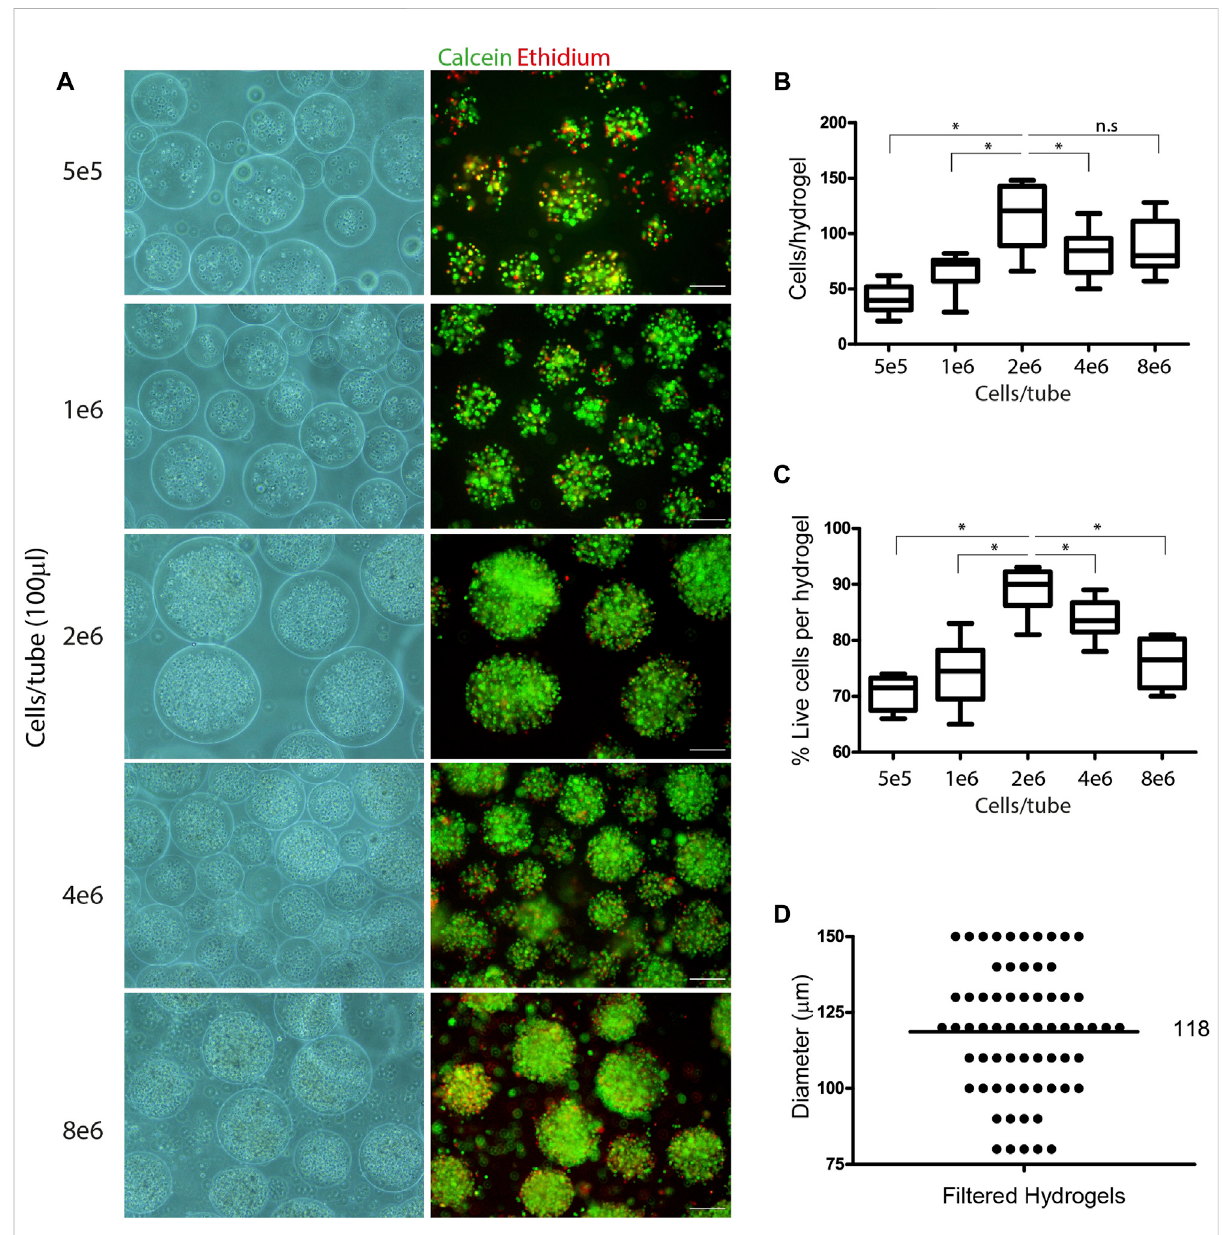
FIGURE 1 Co-encapsulation of alveolar macrophages (MH-S) and epithelial (TC1) cells inside hydrogel microspheres. (A) Representative bright fi eld and fl uorescentimagesofencapsulatedMH-Scellsinelevatednumberofcellsperreaction(5×10 5 -8x10 6 cells/100 µlinaglasstube).Encapsulatedcells werestainedwithCalcein(green)andethidium(red)forlive/deadassay.Scalebar100 µm. (B) Boxplotshowingmedianofencapsulatedcellnumber per hydrogel microspheres using elevated number of cells per reaction tube (5 × 10 5 -8x10 6 cells/tube). The presented results are from ten individual microspheres, a representative from three independent experiments. (C) Box plot showing live cell percentiles inside microspheres measured by live/dead assay in elevated number of cells per reaction tube (5 × 10 5 -8x10 6 cells/tube). The presented results are from ten individual microspheres, representative of three independent experiments. (D) Dot plot showing microsphere diameter after fi ltration using 150 µm cutoff fi lter. The average of 118 µm is shown in black line. The presented results are from three different experiments in which each experiment was represented by at least twenty individual microspheres that were measured. * p value < 0.05 tested in Wilcoxon non-parametric test; n.s, not signi fi